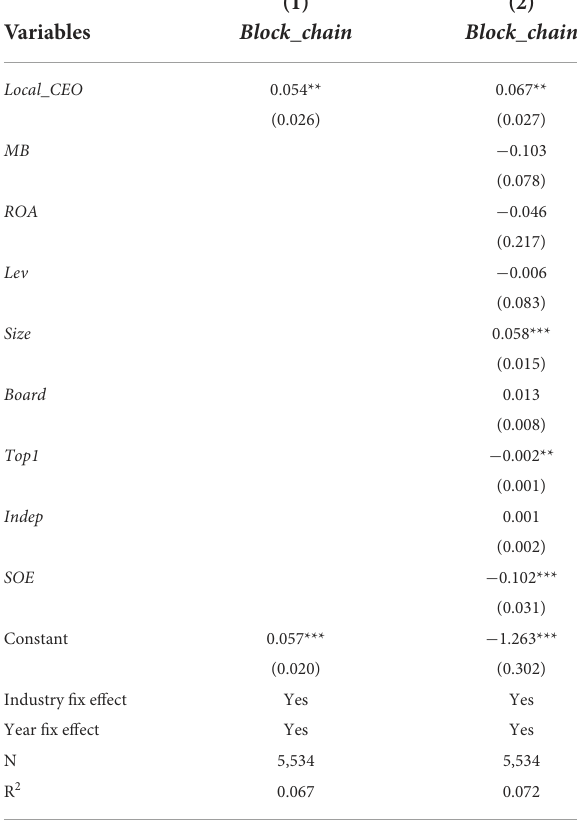
TABLE 3 Benchmark regression